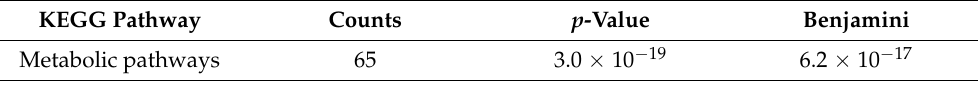
Table 4. Genes from significant KEGG pathways coding for differential hepatic expression of